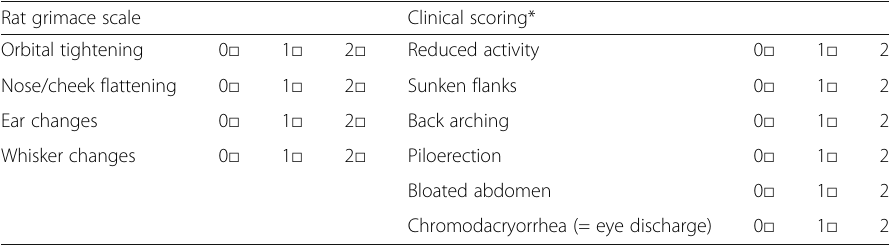
Table 1 Score sheet to assess sepsis-induced behaviour changes Rat grimace scale Clinical scoring* Orbital tightening Nose/cheek